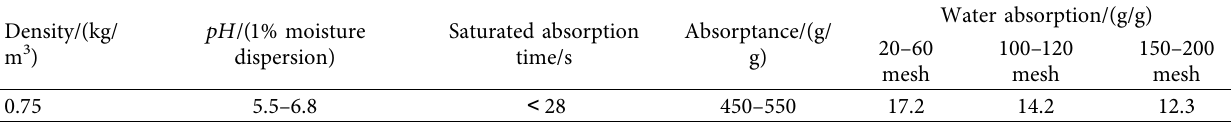
Figure 1: Micromorphology of SAPs in the dry state. (a) 50 times; (b) 200 times. Table 1: Main technical indicators of SAP.